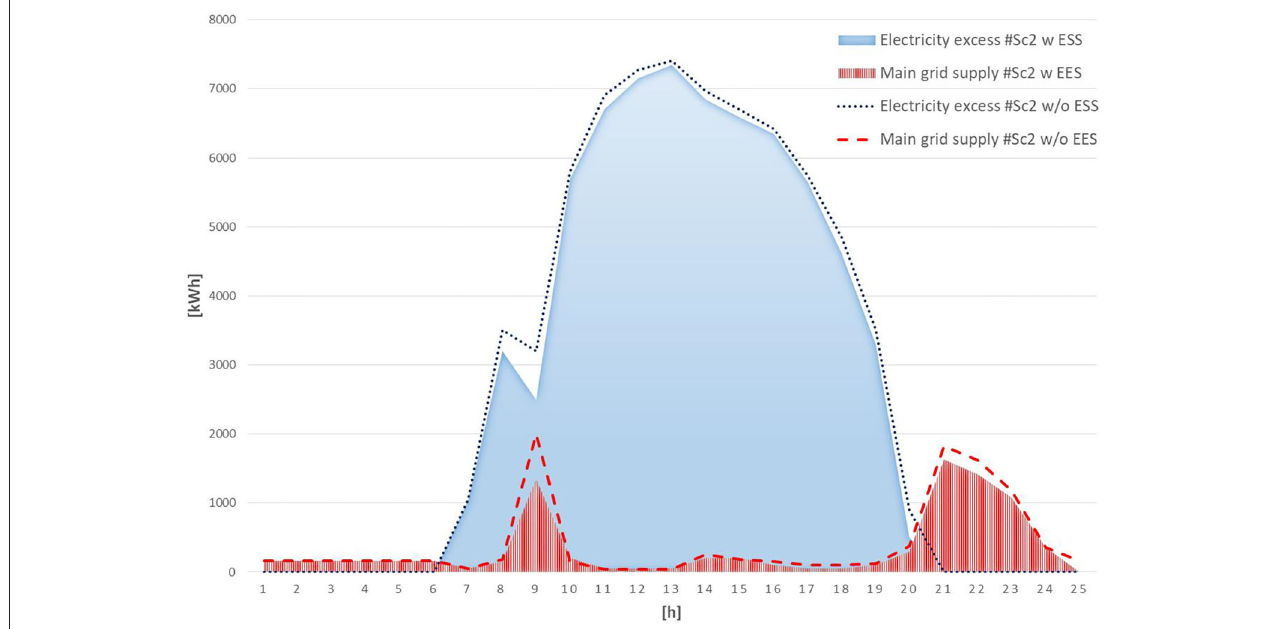
FIGURE 7 | Hourly electricity balance and main grid supply for #Sc2.